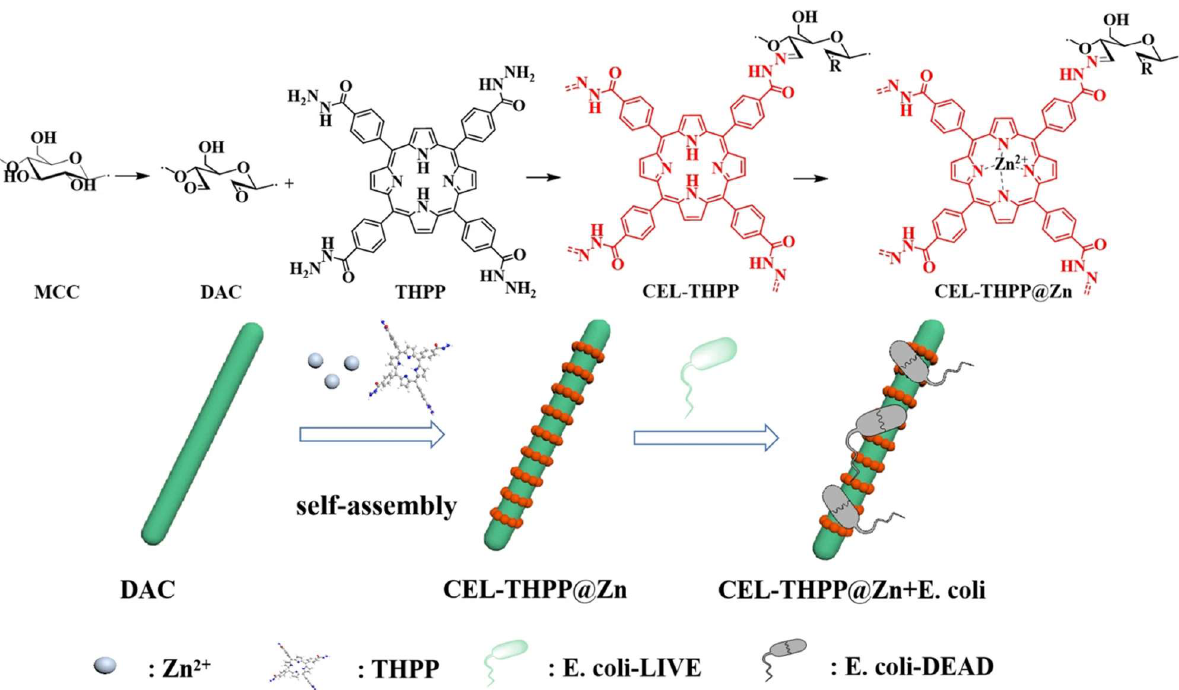
Figure 17. Synthetic methodology used to covalently graft porphyrin 5,10,15,20-tetrakis(4-hydrazinecarbonylphenyl)porphyrin (THPP) on oxidized cellulose containing aldehyde groups (DAC), Reprinted with permission from Ref. [159] . 2009., Springer Nature.